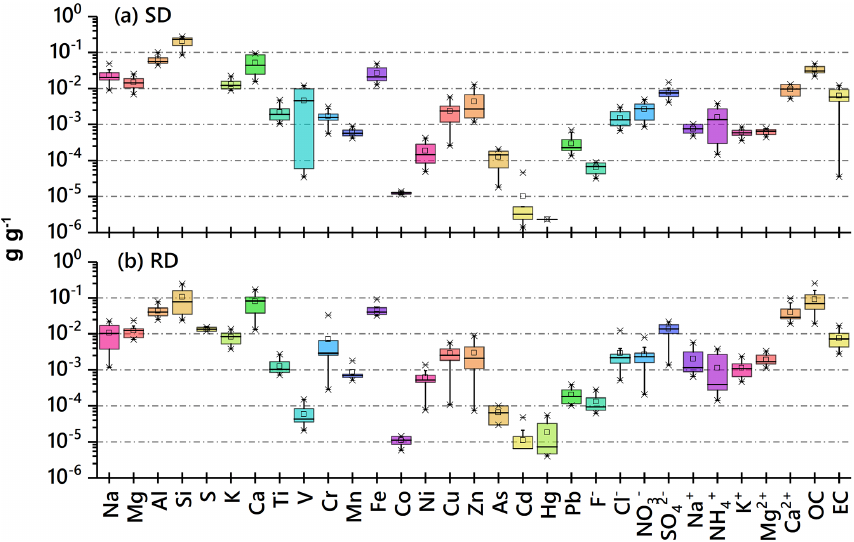
Figure 11. Characteristics of chemical profiles for PM emitted from fugitive dust. SD and RD denote soil dust and road dust, respectively. Data were acquired from the Nankai University source